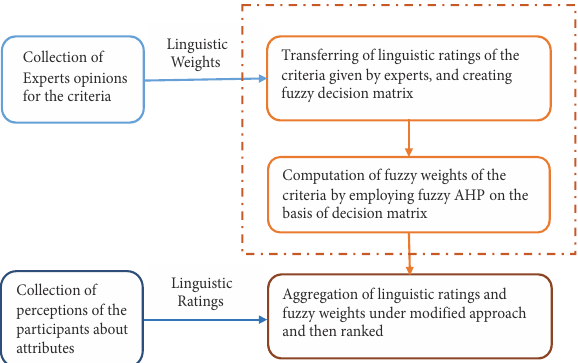
Figure 3. Chen’s fuzzy